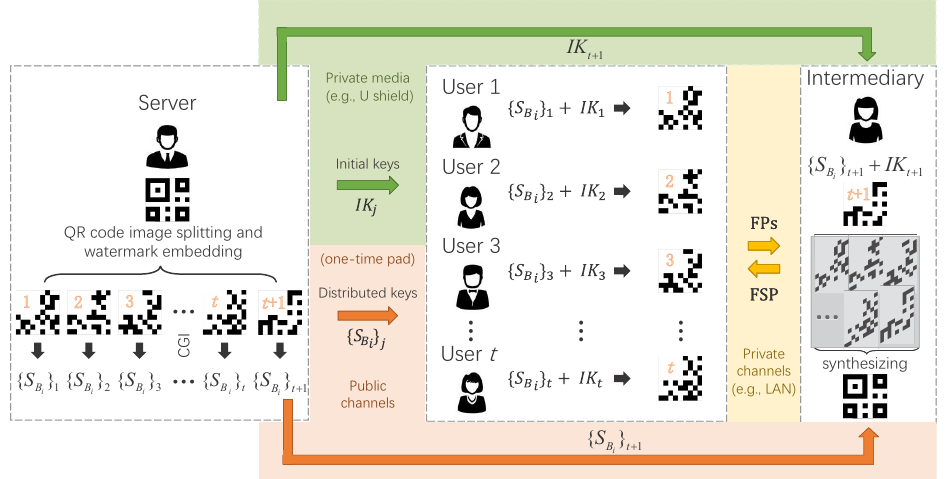
Figure 1. Schematic of a multi-party cryptographic key distribution (CKD) protocol over a public network based on a quick-response (QR) code. FPs: fragment patterns; FSP: fragment synthesis